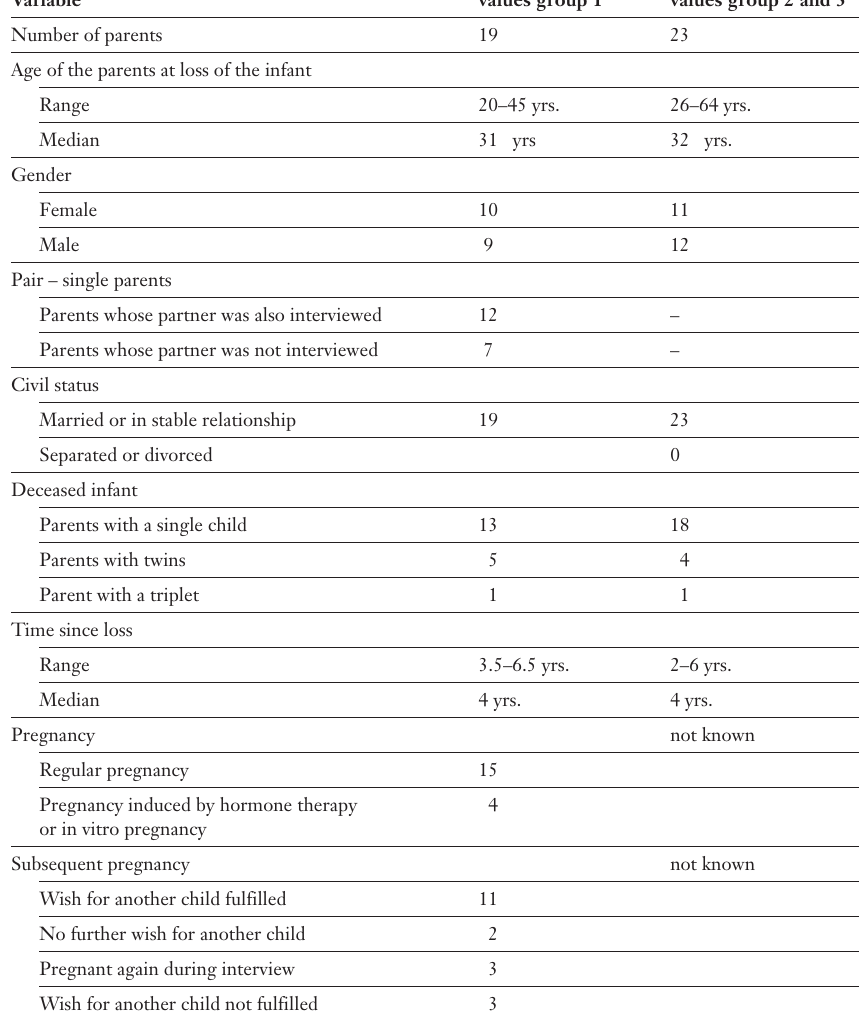
Description of the 19 interviewed parents (group 1) and the 23 parents who refused to give an interview (group 2, N =18) or whose interview was not included in the analysis (group 3, N =